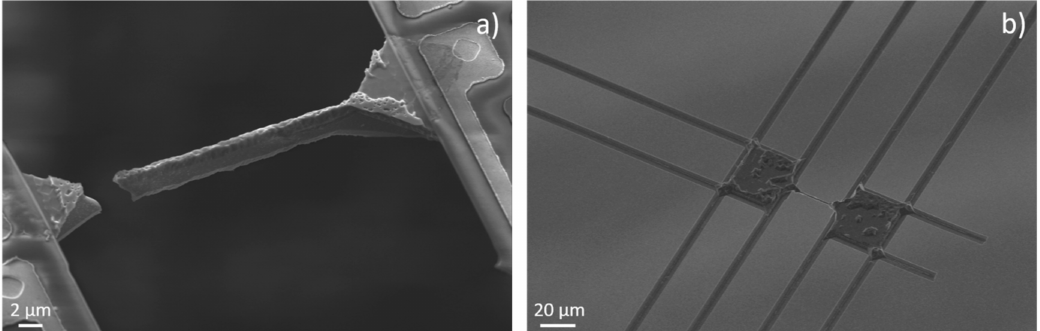
Figure 6. ( a ) Broken silicon beam between the platforms due to the internal tensile stress. ( b ) A device with two broken supporting SiN/Pt bridges reducing the internal tensile stress inside the silicon beam and enabling further reduction in the cross-sectional area of the silicon